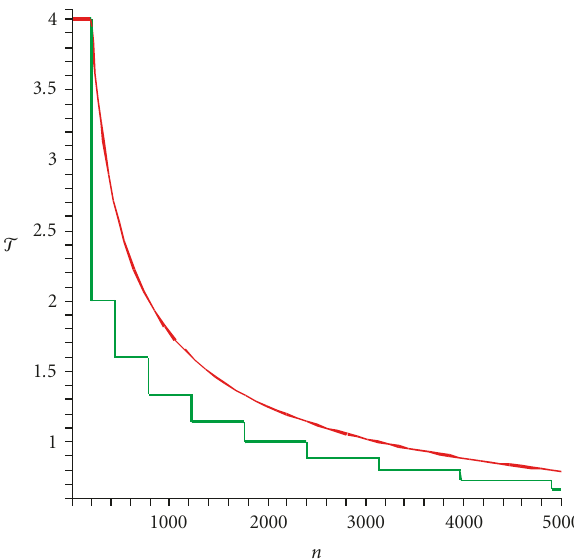
Figure 12: Throughput T versus n (upper and lower bounds) for beamwidth of 10 degrees.